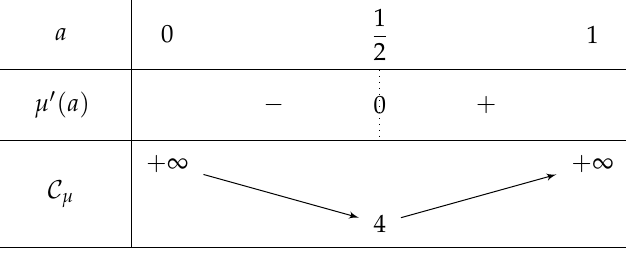
Figure 3. Variation table of µ